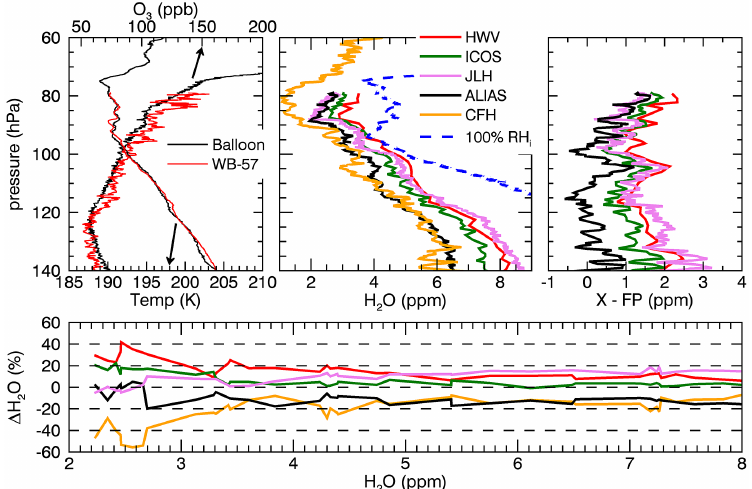
Figure 1. Profiles of water vapor mixing ratios from three core instruments included in the AquaVIT-1 intercomparison (CFH, HWV, and JLH), the Aircraft Laser Infrared Absorption Spectrometer (ALIAS; Webster et al., 1994), and the Integrated Cavity Output Spectroscopy (ICOS) instrument (Sayres et al., 2009). All measurements were made in situ near San Jose, Costa Rica, on 1 February 2006. The CFH measurements were made from a small balloon launched near the San Jose airport. The other measurements were made onboard the NASA WB-57F high-altitude research aircraft on descent into the San Jose airport. Top left panel: profiles of temperature (bottom axis) and O 3 (top axis) versus ambient pressure measured from the WB-57F (red) and balloon (black) showing good correspondence between air masses sampled from these different platforms. Top middle panel: water vapor mixing ratios measured by the balloon and aircraft instruments. Saturation mixing ratios (blue dashed line) were calculated using balloon temperature and pressure. Top right panel: vertical profiles showing differences between each of the WB-57F instruments and the FP (CFH) balloon instrument. Bottom panel: deviations from a mean profile (mean profile consists of equally weighted HWV, ICOS, JLH, ALIAS, and CFH) for HWV (red), ICOS (green), JLH (violet), ALIAS (black), and CFH (gold)). From Rollins et al.